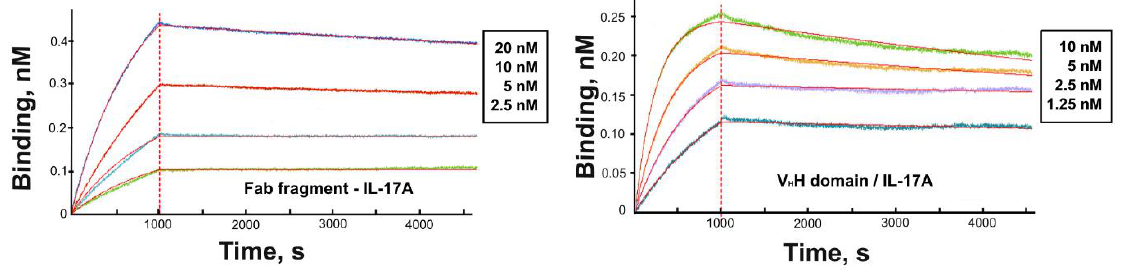
Figure 3. Sensograms of the interaction of the V H H domain (alone or as a part of the Fab fragment) with IL-17A. The experimental curves are shown in different colors while fitted curves are in red.